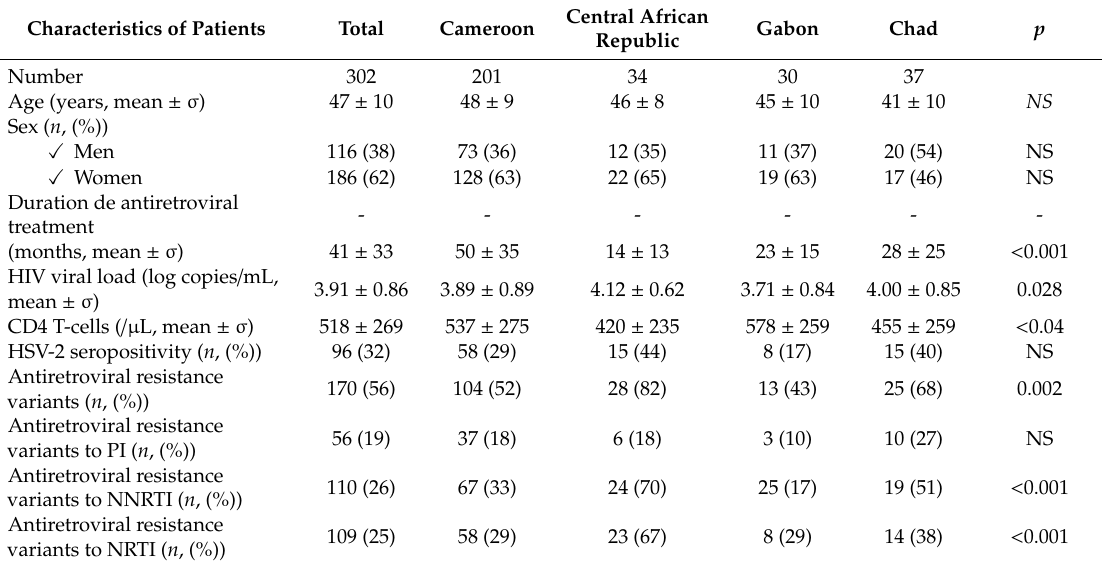
Table 1. Characteristics of patients under first-line antiretroviral treatment experiencing virological failure in Central